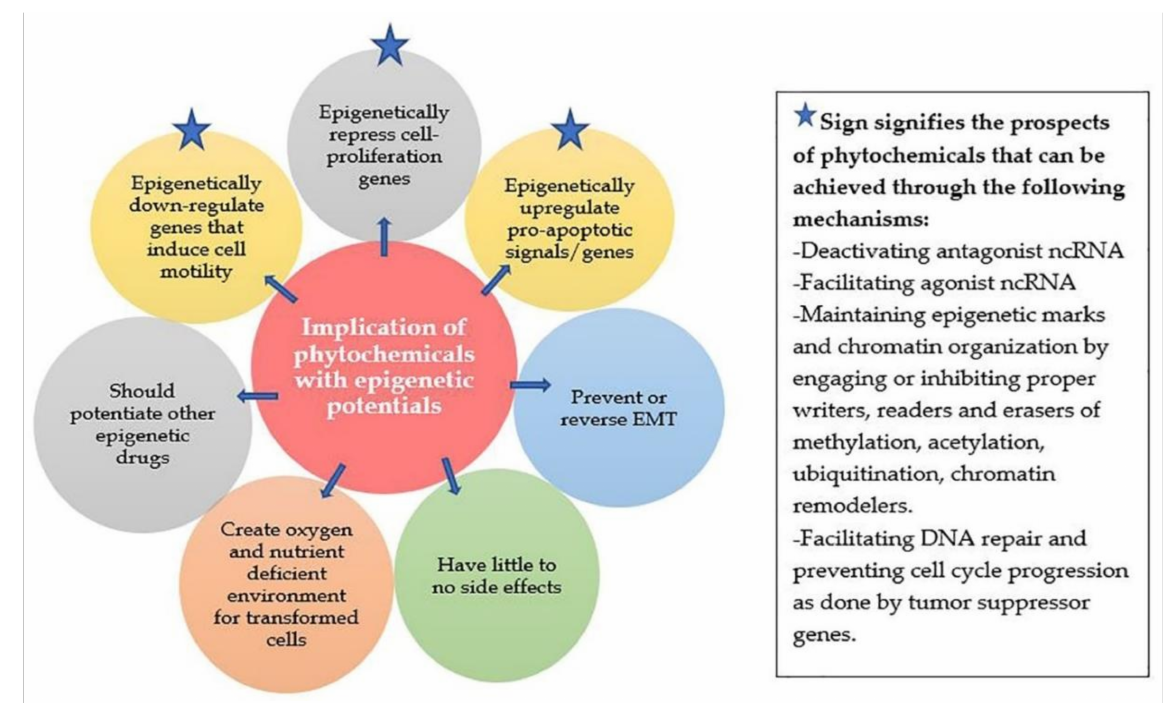
Figure 2. Factors that an effective phytochemical should control epigenetically for controlling cancer